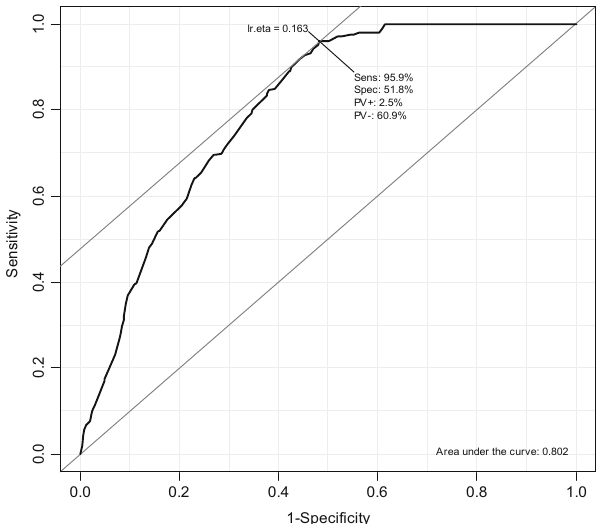
Fig. 5 ROC curve for the multiple logistic regression model in Table